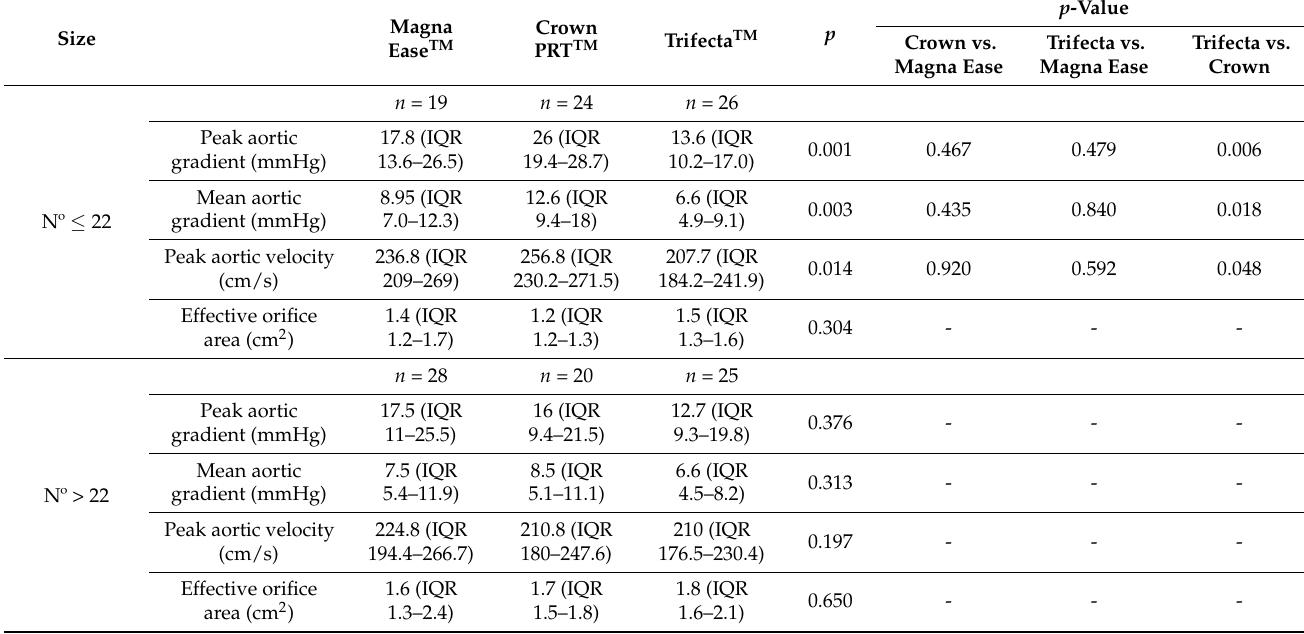
Table 4. Echocardiographic finding stratified by aortic annulus size at 12 months after surgery.